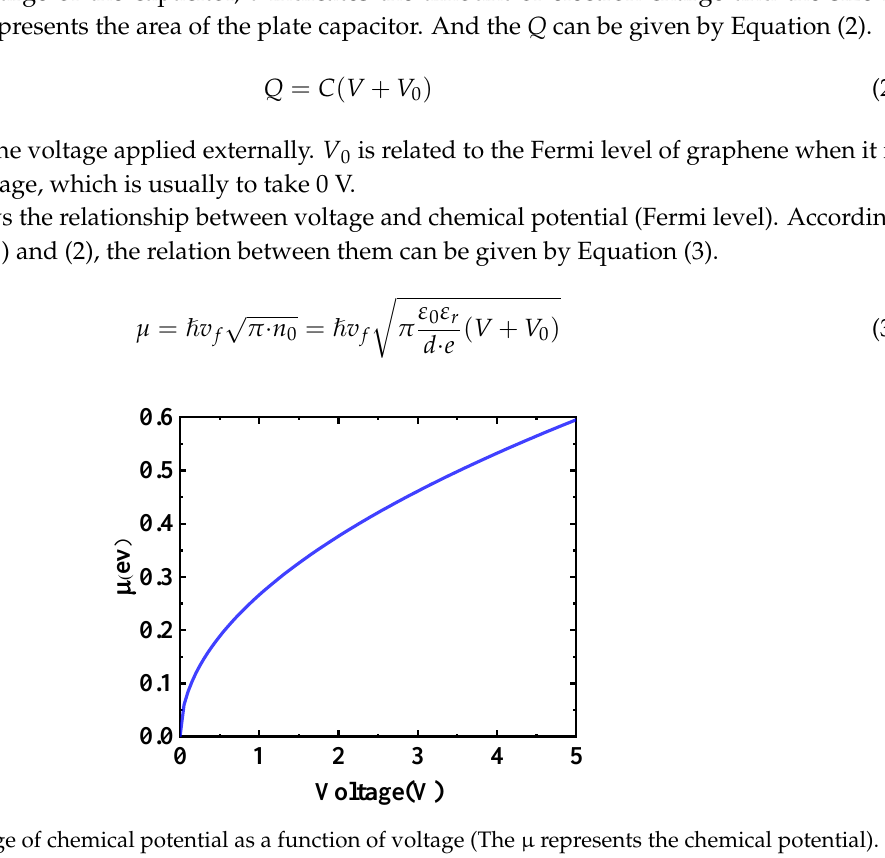
Figure 2. The image of chemical potential as a function of voltage (The µ represents the chemical potential).